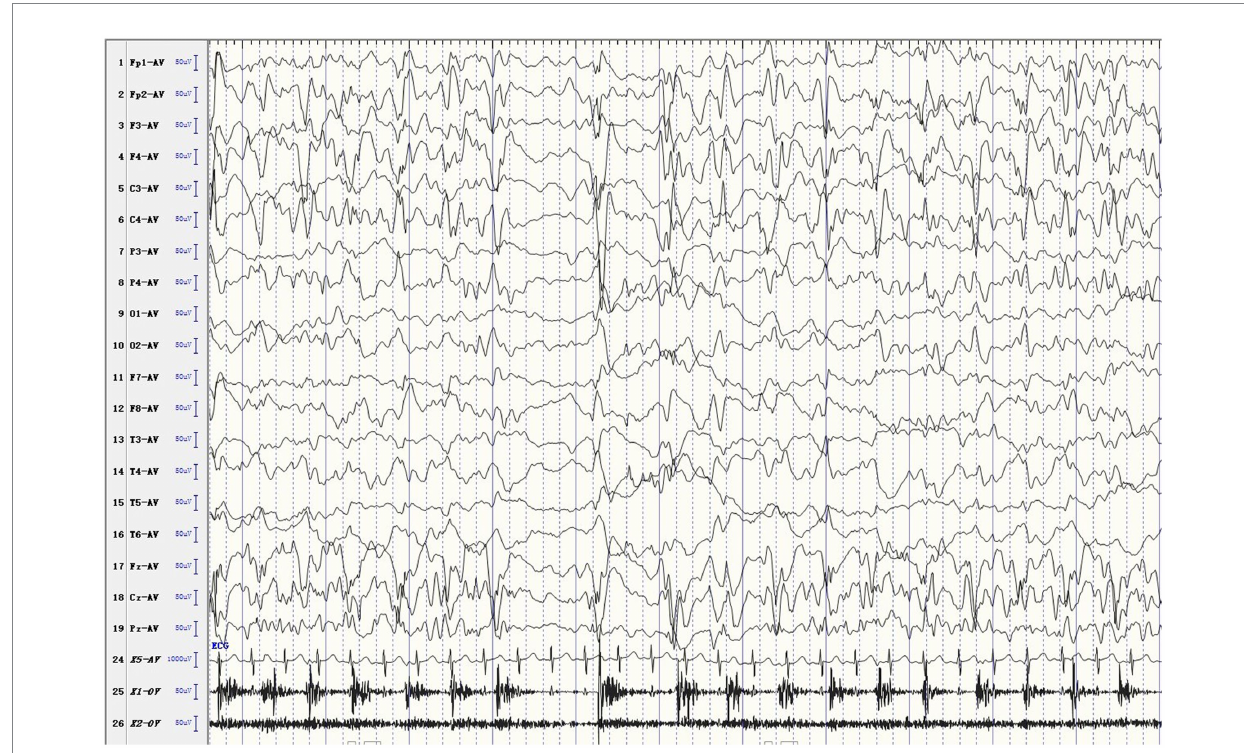
FIGURE 1 Ictal EEG. The patient developed rhythmic jitter of the left limb, and EEG showed mixed fast and slow waves and sharp waves in the right